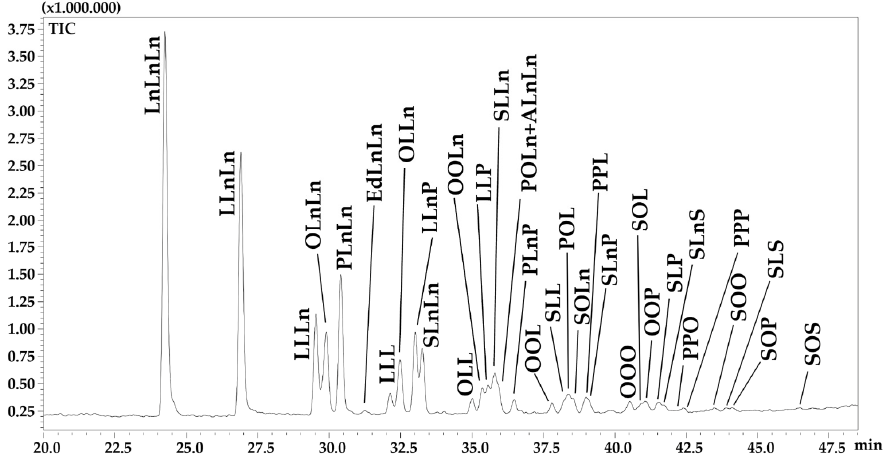
Figure 2. Expansion of NARP-HPLC-APCI( + )-qMS chromatogram of TAGs in Chia seed oil. Table 4. Identified TAGs, along with CN, DB, PN and their mean % content in Chia seed oil. TAGs